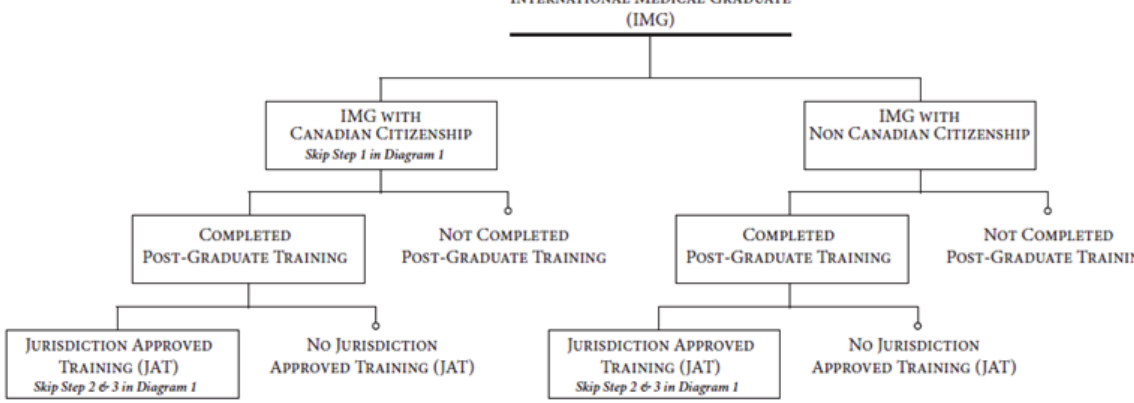
Figure 1. Understanding international medical